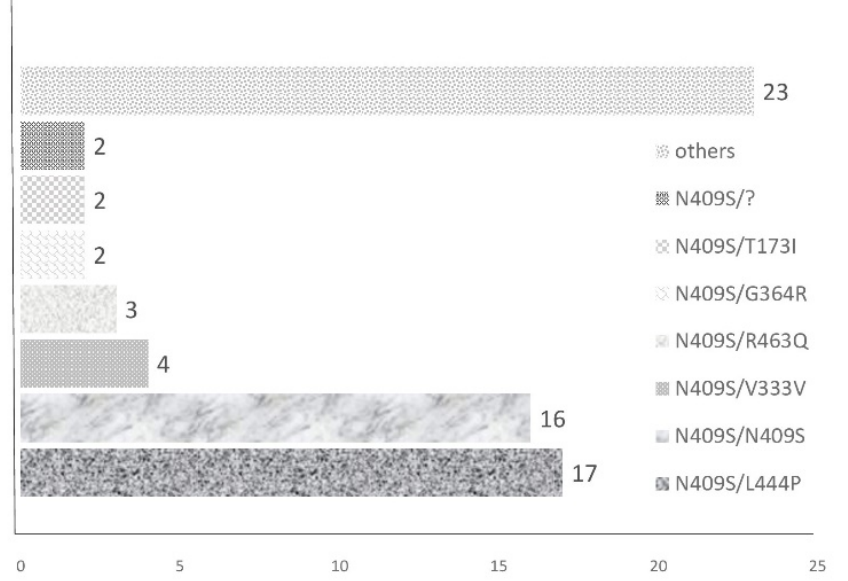
Figure 1. Genotype of GD type 1 patients. Others: N409S/recA456P, N409S/RecNcil, N409S/c.398*; G394R, N409S/c.115 + 1G>T, N409S/1265_1319del, N409S/D419N, N409S/D438N, N409S/F252S, N409S/G416H, N409S/G429V, N409S/H350, N409S/R159W, N409S/R463C, N409S/R463H, N409S/S146L, N409S/T270I, N409S/T291I, N309S/H350P, N309S/RecNcil, N409S/R502H, R463H/R463H, W223R/N409S, p[W387*]; [W387*]. Systolic pulmonary artery pressure (SPAP) was estimated by cardiac ultrasound. Most patients exhibited an SPAP under 30 mmHg, with the mean SPAP being 28 mmHg (Figure 2).